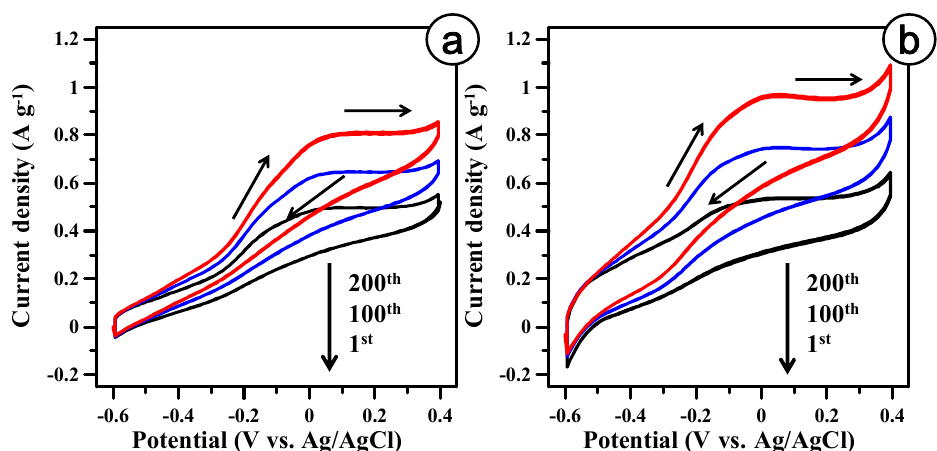
Figure 6. Typical cyclic voltammetry (CV) profiles of ( a ) N-doped GQD and ( b ) B-N-codoped GQD electrodes in 1 M glucose + 1 M NaOH electrolyte at 50 mV s − 1 .